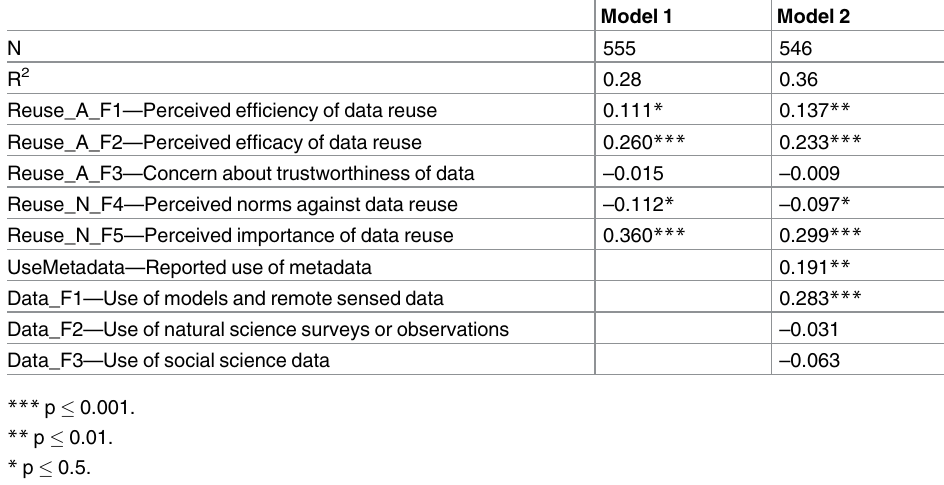
Table 5. Regression